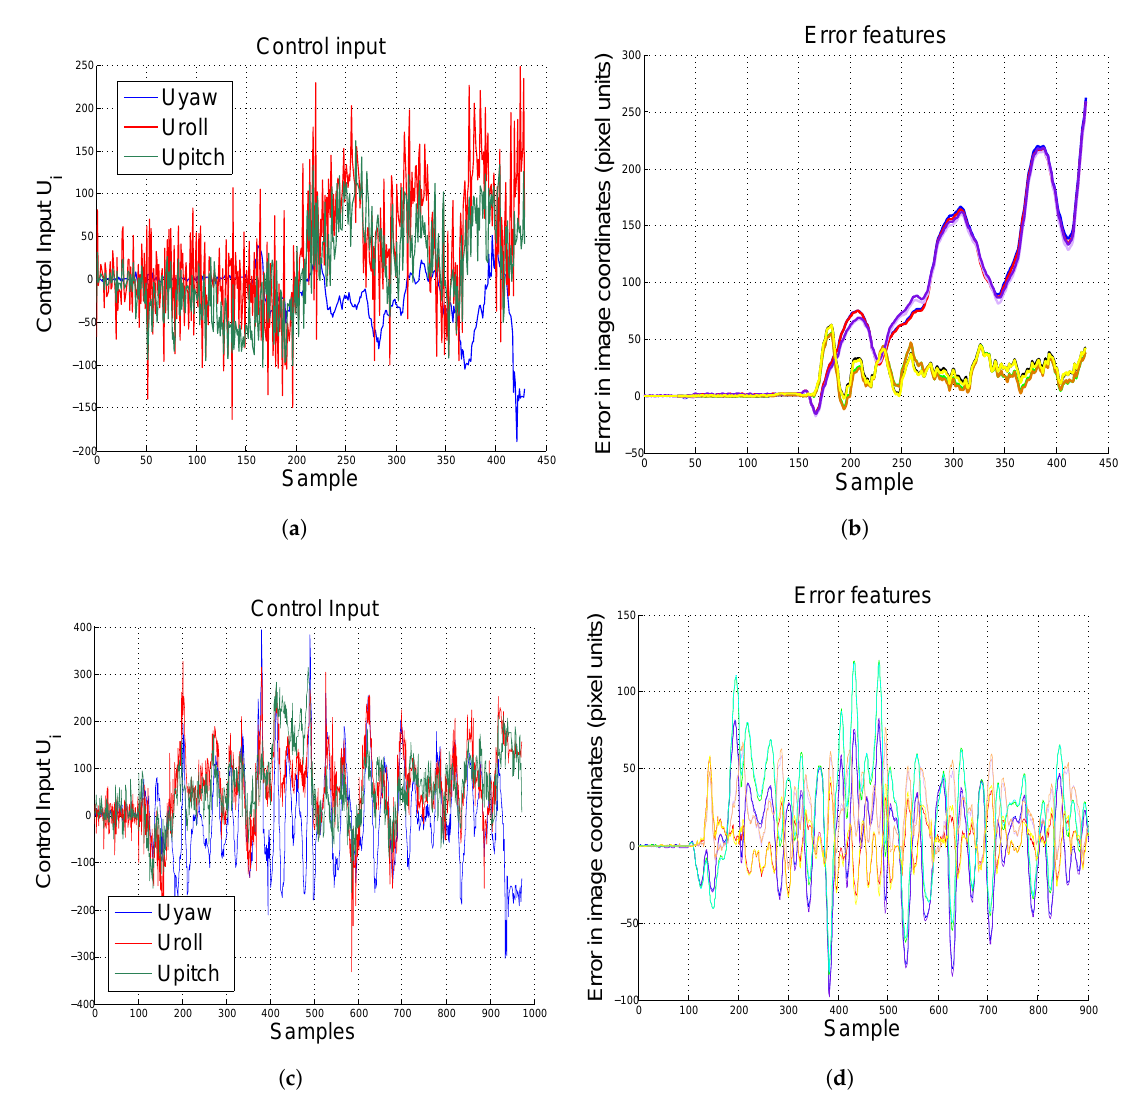
Figure 11. Experimental results when mass and moment of inertia changed. The pattern remains at the same position during the test. ( a ) control input conventional PID; ( b ) error conventional PID; ( c ) control input ANN-PID; ( d ) error ANN-PID.